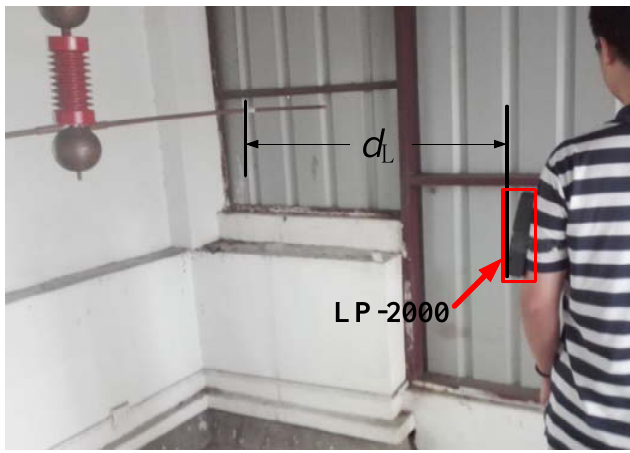
Figure 13. Electric field measurements in different distances (in the case of an approaching human body). Table 8. Corrected data statistics with different measurement distances (in the case of an approaching human body).